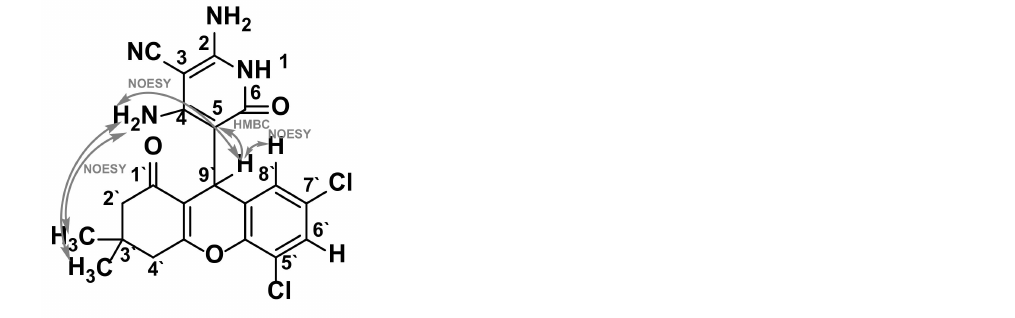
Figure 5. The structure of 5-(2,3,4,9-tetrahydro-1 H -xanthen-9-yl)-6-oxo-1,6-dihydropyridine 2a . Key 2D NMR correlations are shown by arrows.